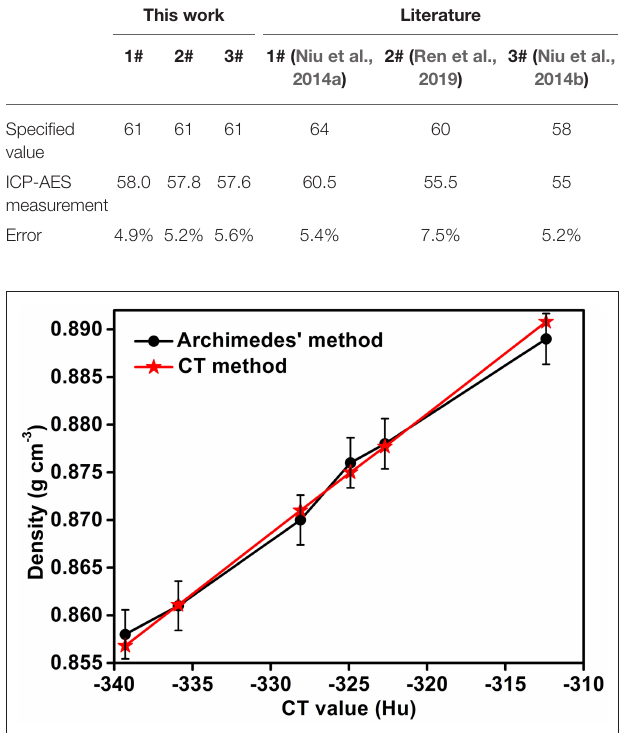
FIGURE 9 | Comparison of the densities as measured by the Archimedes and the CT